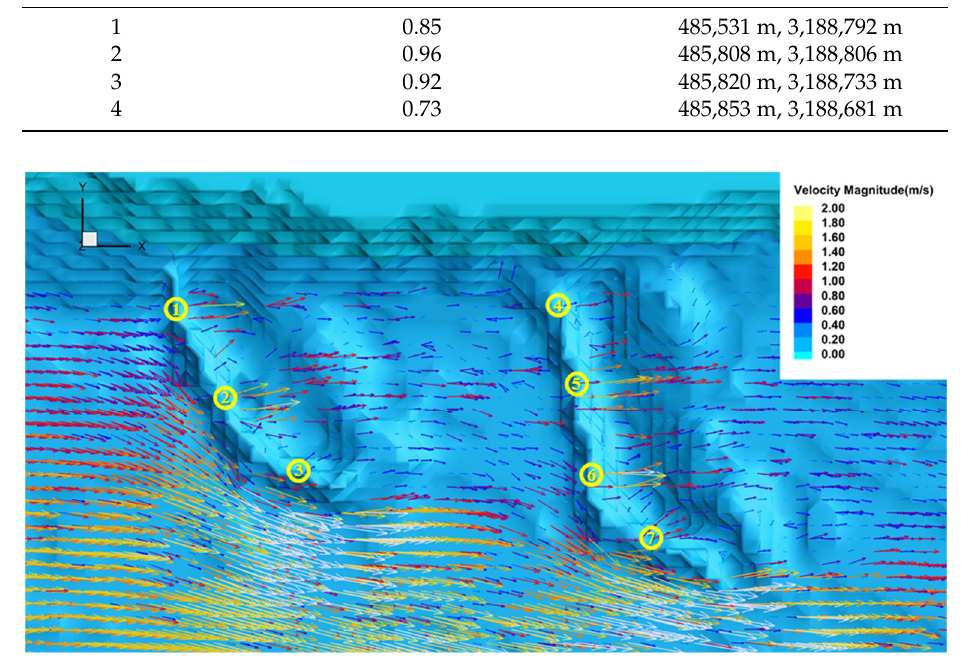
Table 3. Flow velocity at the potential damage positions in shallow submerged condition. Location No.